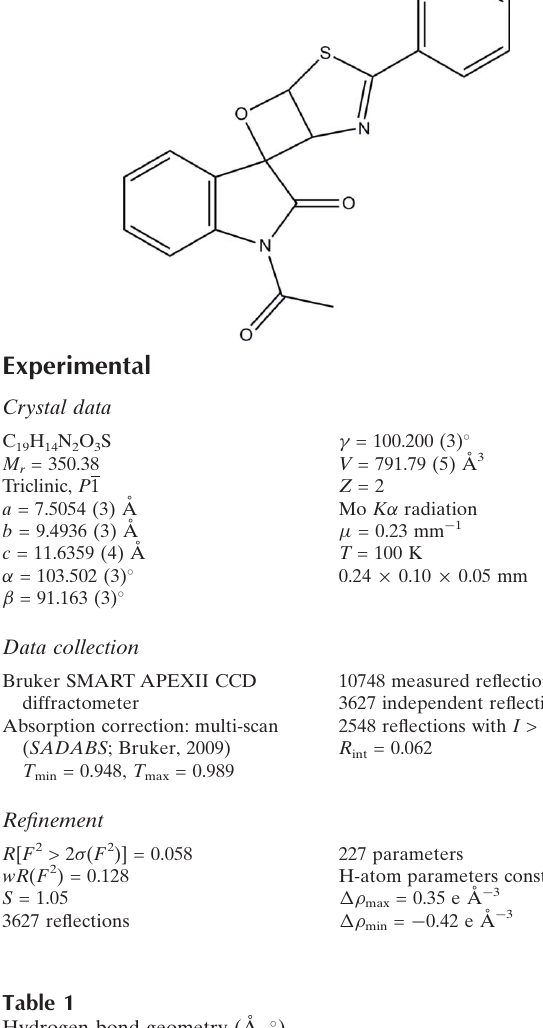
Hydrogen-bond geometry (A˚ , (cid:2) ). Cg 1 is the centroid of C1–C6 phenyl